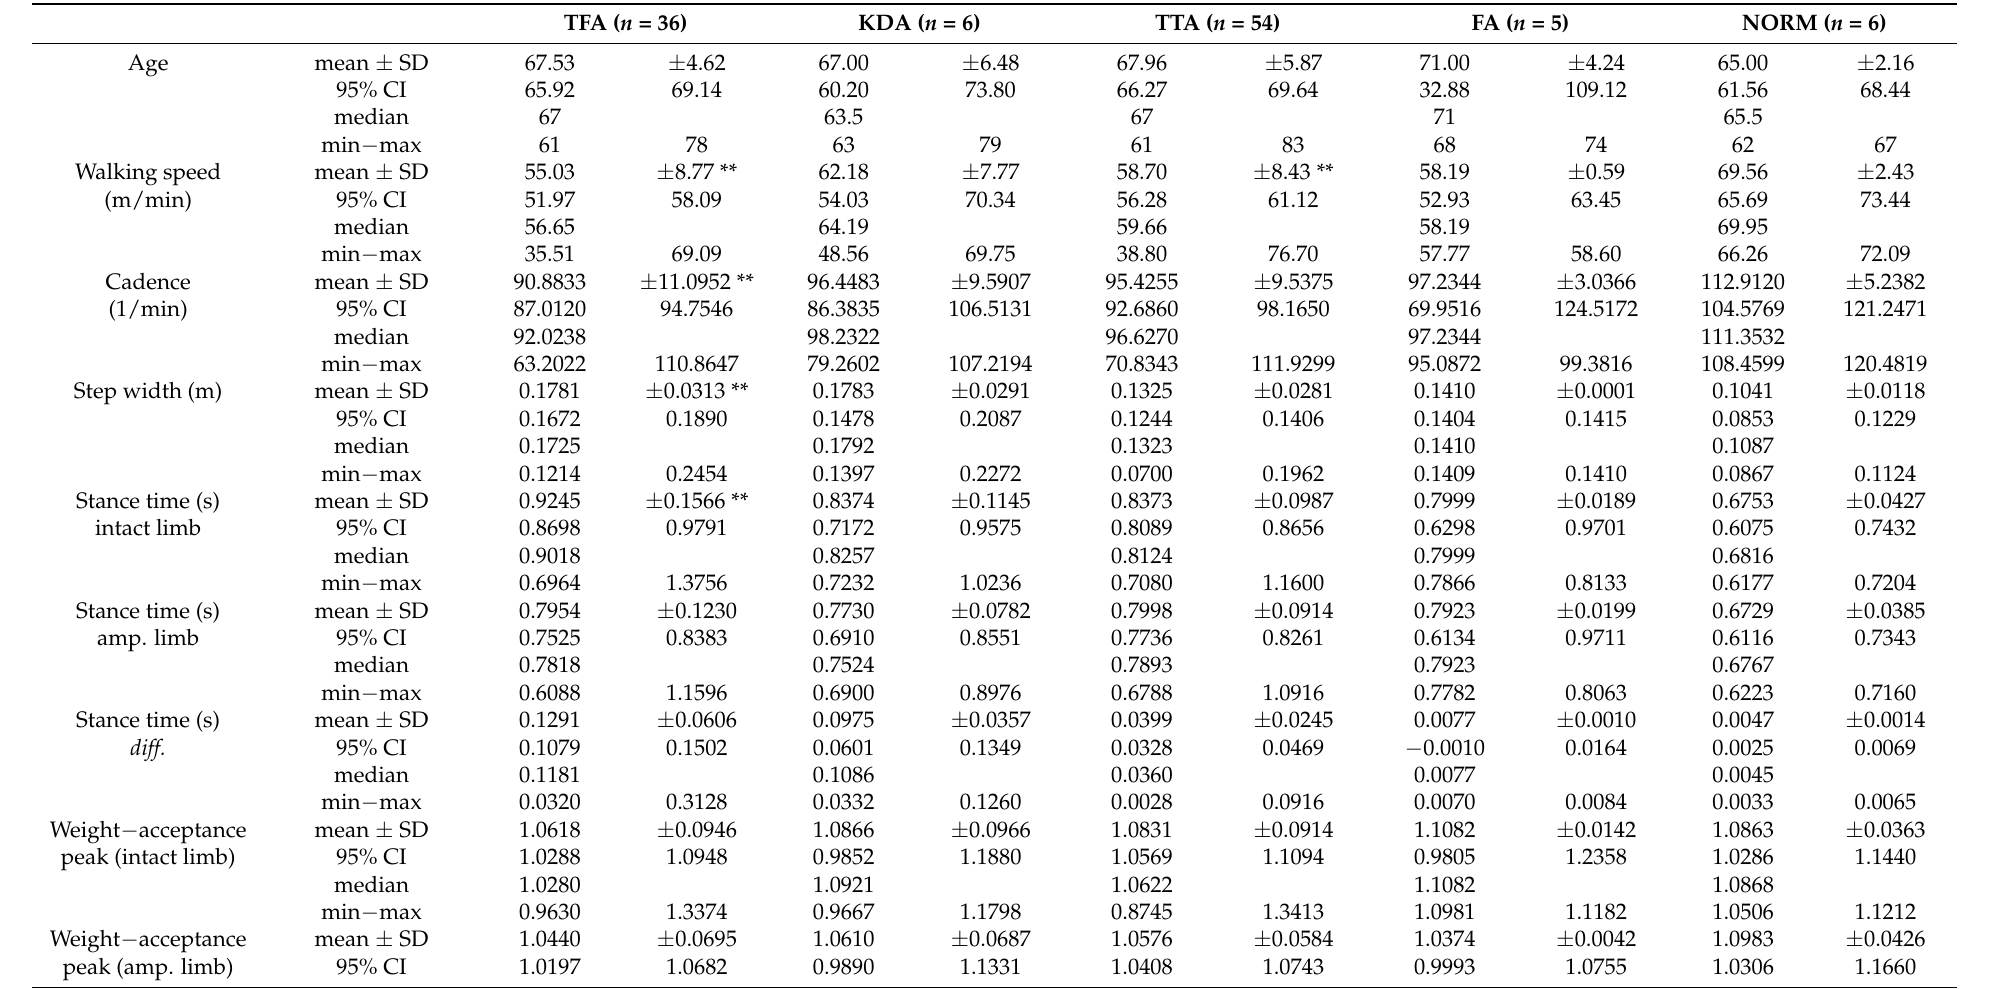
Table 4. Reference values for kinetic gait parameters in unilateral lower limb amputations and physiological gait (age > 60